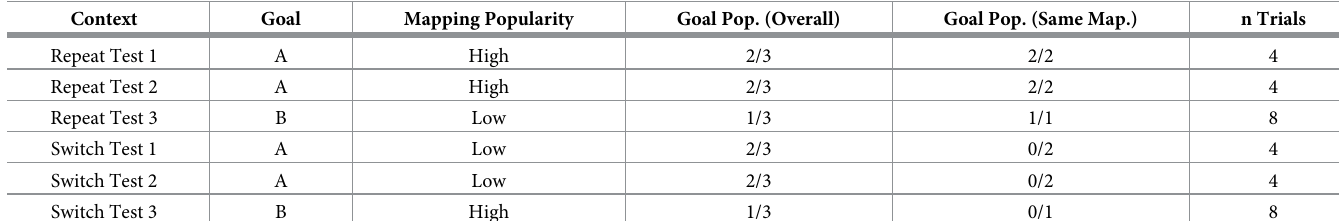
Table 1. Test contexts for experiment 1. Goal popularity, both overall and for contexts with shared mappings, is denoted as the fraction of contexts in training with the same goal. Context Goal Mapping Popularity Goal Pop. (Overall) Goal Pop. (Same Map.) n